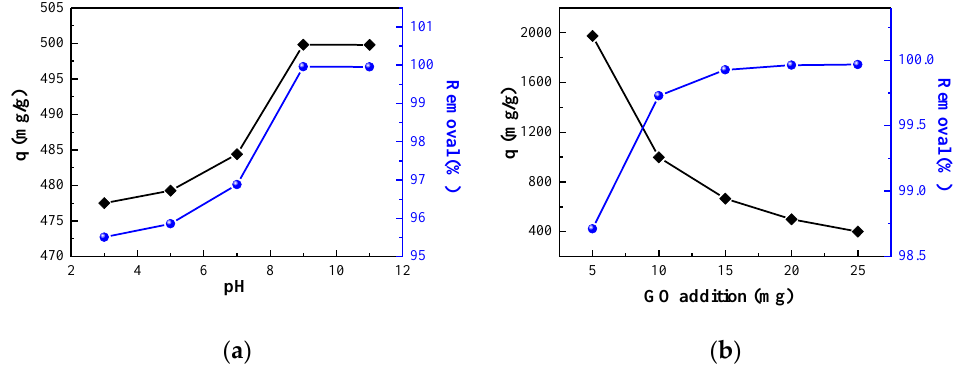
Figure 3. Effect of ( a ) initial pH and ( b ) GO addition on adsorption.